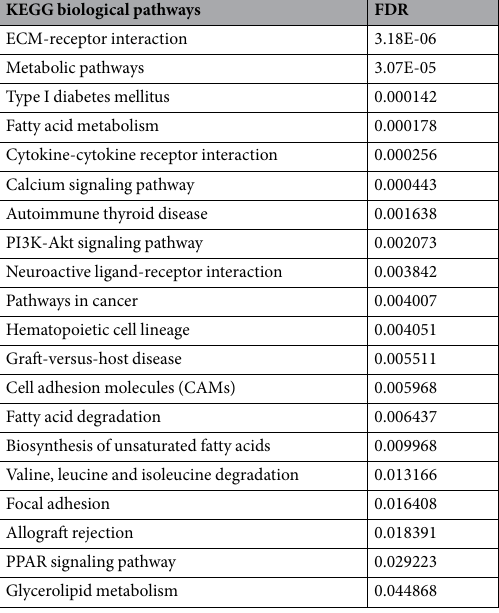
Table 1. List of KEGG pathways enriched in SGBS adipocytes when compared to PHWSC adipocytes. Genes with log (FC) > 0.60 and FDR < 0.05 were used as an input in ipathway guide to generate significantly enriched KEGG pathways (P < 0.05, Bonferonni corrected). Pathways are listed in increasing order of P